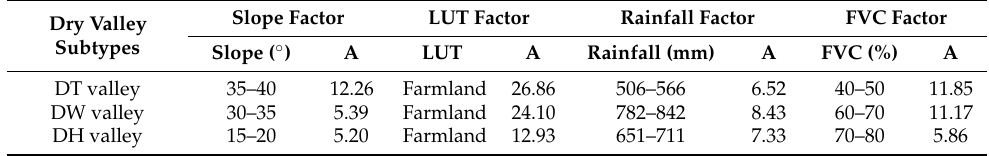
Table 4. Regions at high risk of water erosion in the three dry valley subtypes.